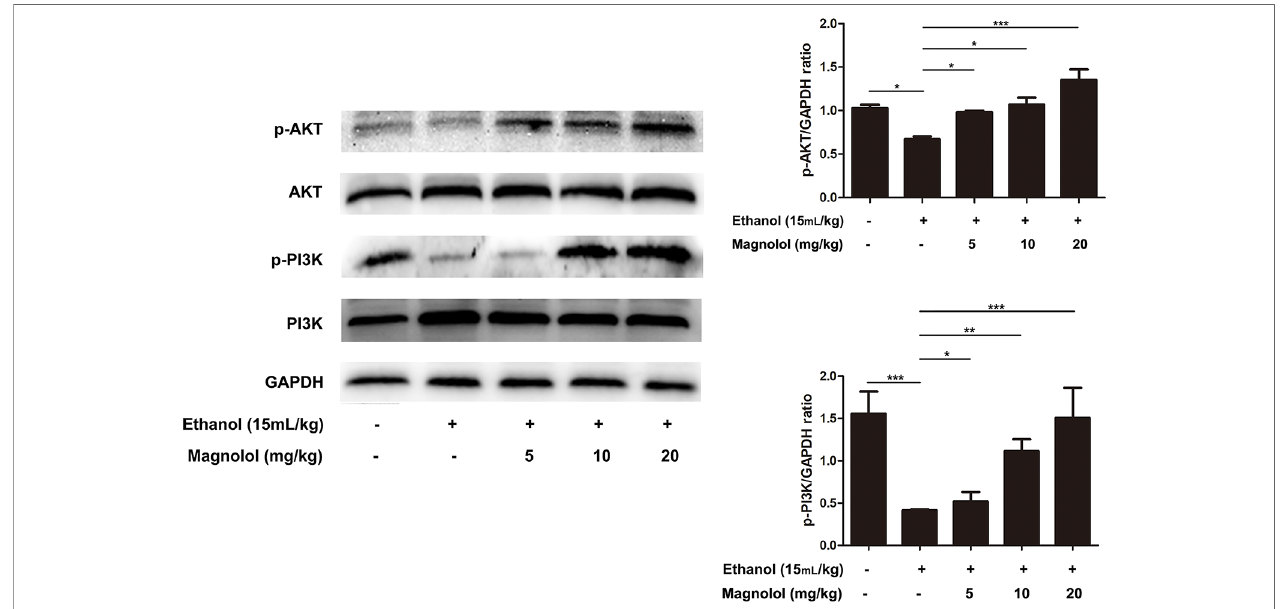
FIGURE 6 | Effects of magnolol on mice alcohol-induced liver damage in the AKT/PI3K signaling pathway. Liver tissues were extracted for protein analysis by western blotting. AKT and PI3K, proteins expression were detected. The levels of AKT and PI3K were compared with GAPDH. The data were demonstrated as means ± SD. (*P < 0.05, **P < 0.01, ***P < 0.001).